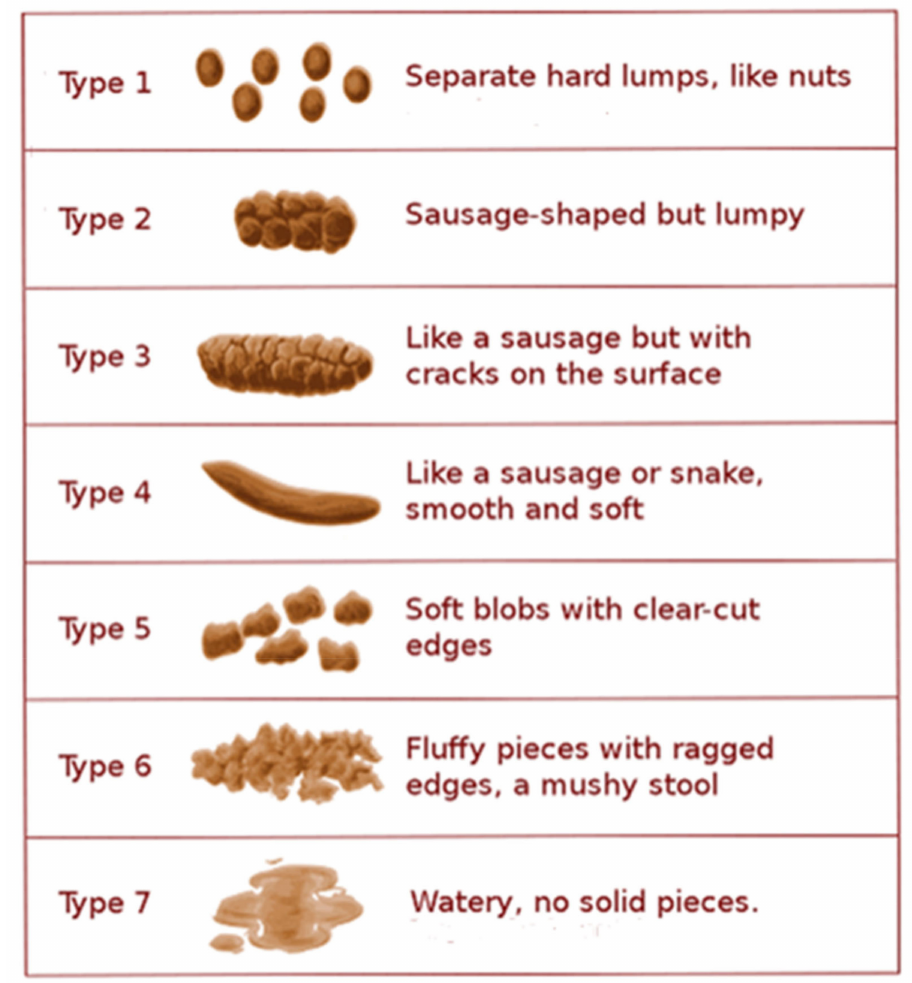
Figure 1. Bristol Stool Form Scale. Copyright 2000 © by Rome Foundation. All Rights